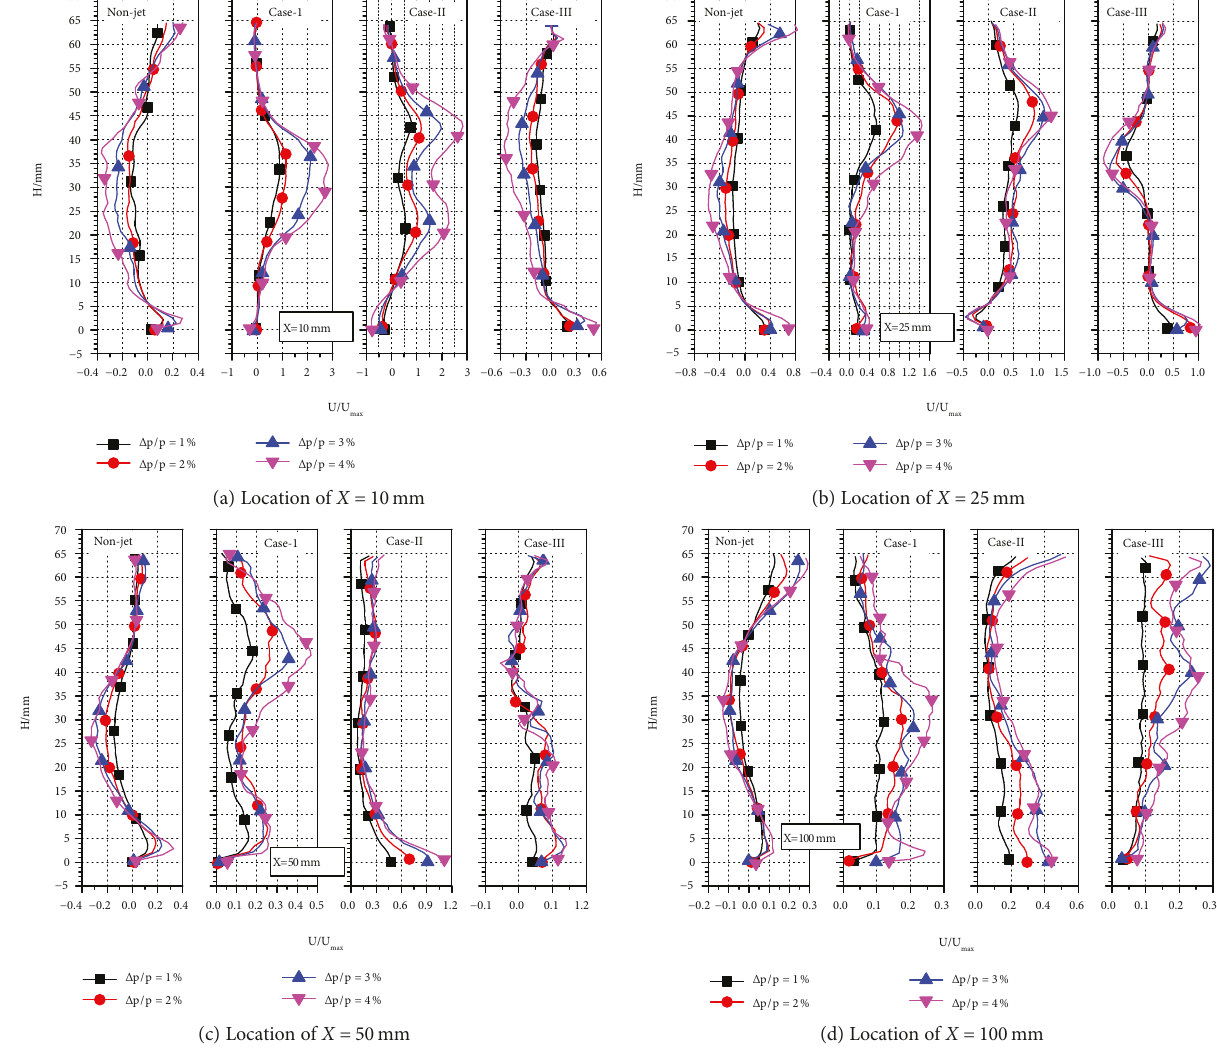
Figure 8: Axial velocity along the Y direction at di ff erent axial locations on the Z = − 15 5 mm